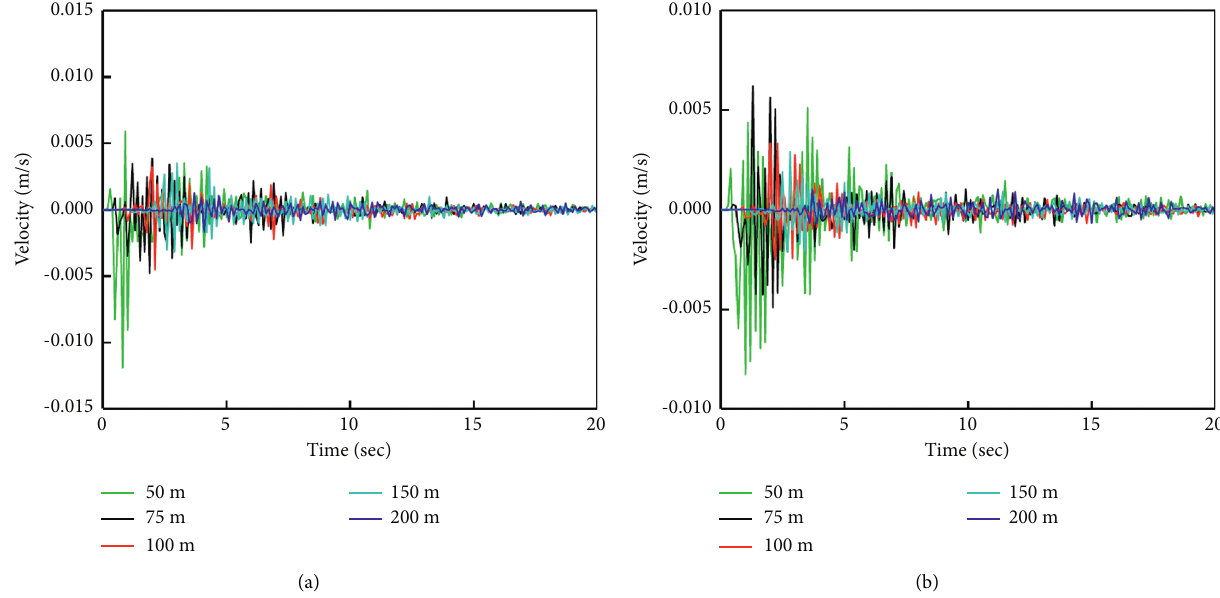
Figure 6: Time-history curves of the peak vertical vibration velocities at different measuring points during double-hammer compaction for different compactor arrangements: (a) east-west (H) arrangement and (b) north-south (V)